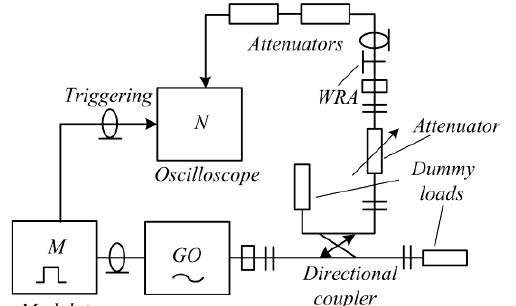
Figure 4 – Measuring circuit for the standard deviation of phase delay